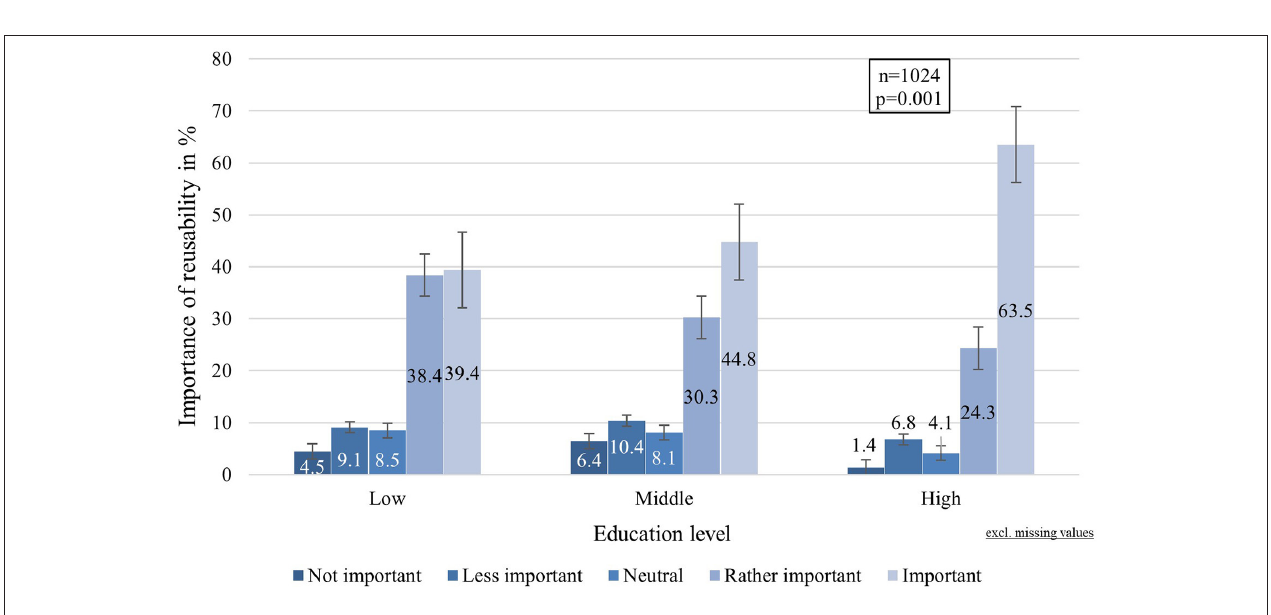
FIGURE 2 | Importance of reusability by education